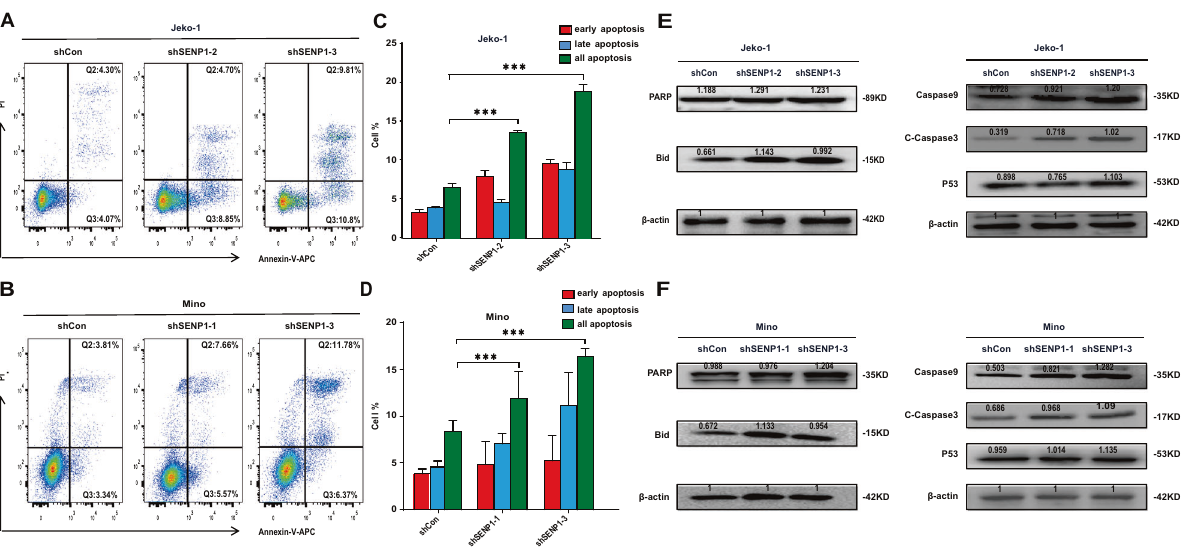
Fig. 3 SENP1 knockdown increases apoptosis of MCL cells. The apoptosis of transfected Jeko-1 ( A ) and Mino ( B ) cells was measured by Annexin V-APC and PI double staining and fl ow cytometric analysis. Representative fl ow cytometry patterns from different groups were shown. The percentages of apoptotic cells of transfected Jeko-1 ( C ) and Mino ( D ) cells were calculated according to the fl ow cytometric results. The protein levels of PARP, Bid, Caspase9, C-Caspase3 and P53 were measured by western blot in transfected Jeko-1 ( E ) and Mino ( F ) cells. Data were presented as mean ± SD and analyzed by two-sided Student ’ s t test. n = 3; *** P <